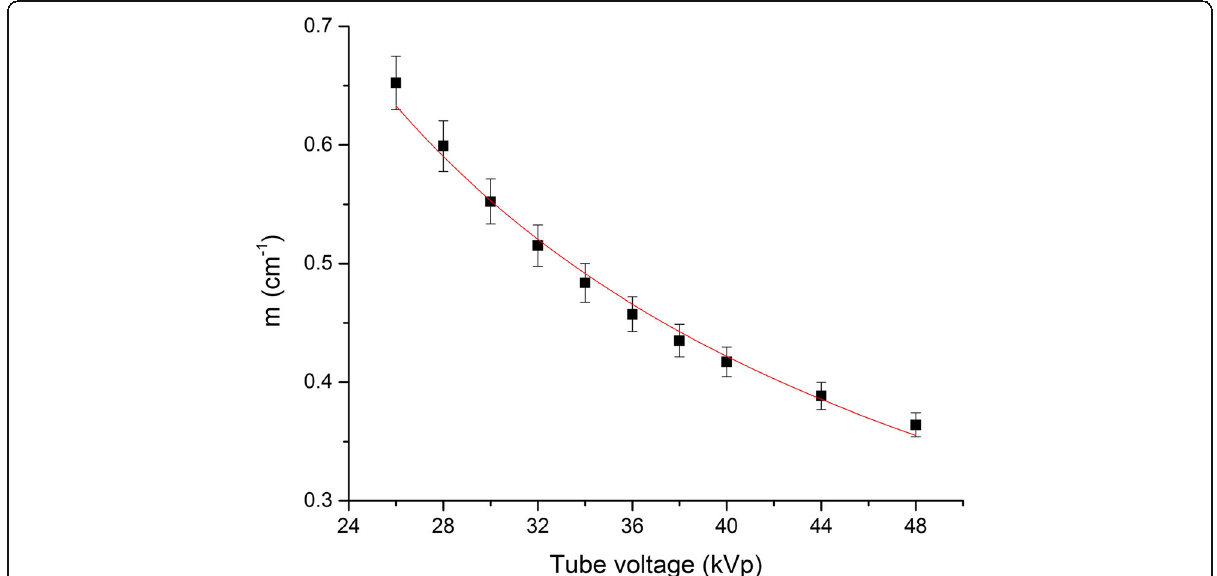
Fig. 2 Coefficient m estimated from measurements in the phantom, expressed as a function of tube voltage. A power function (Eq. (5)) was applied to model the m as a function of the tube voltage